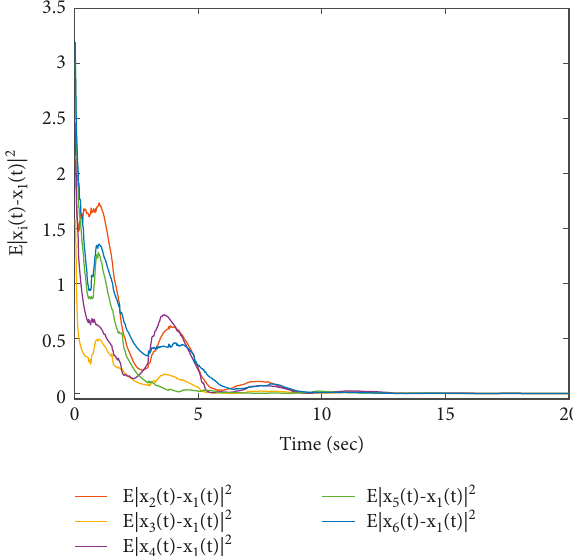
( t ) − x ( t )| 2 of Example i 1